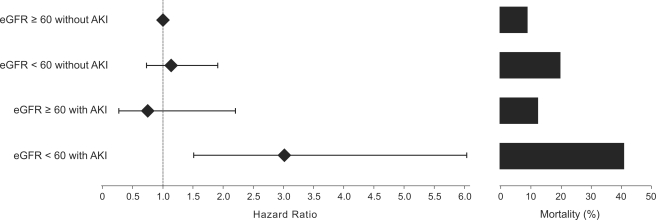
Hospital admission eGFR, AKI development and 30-day to 1-year mortality rates after acute myocardial infarction.Hazard ratio (Cox multivariate analysis, left) and crude mortality (right). Note that only the combination of an admission eGFR<60 mL/min/1.73 m2 with AKI was associated with a higher late mortality. * 30-day to 1-year mortality rates were estimated for patients who survived for 30 days after AMI.